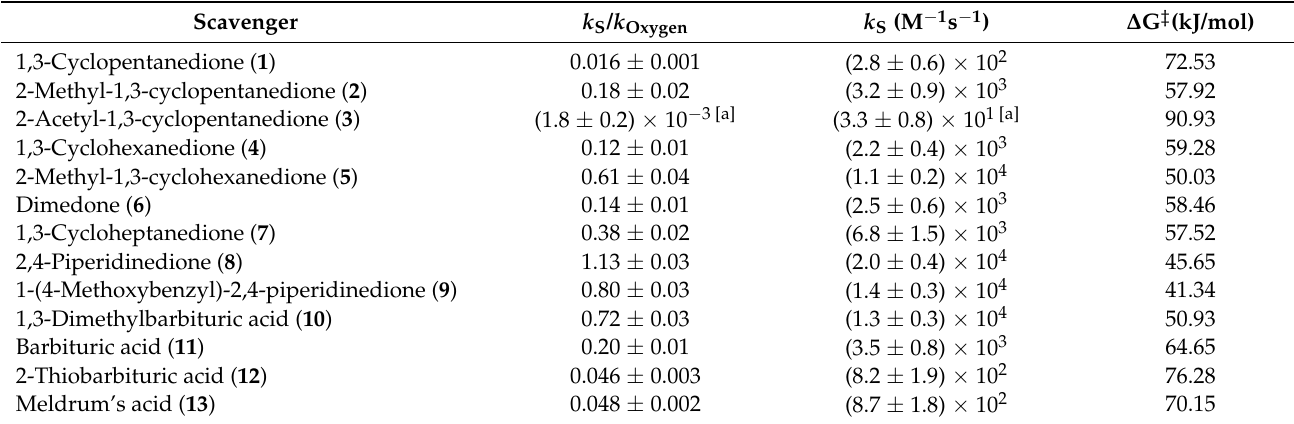
Table 1. Values of the k S / k O2 ratio (average values from at least three independent experiments; pH 7.4, 25 ◦ C) for the studied cyclic C -nucleophiles, with the rate constants for their reactions with HNO and theoretically calculated Gibbs free energy barriers at the B2PLYP-D3/6-311+(2df,2p) theory level.